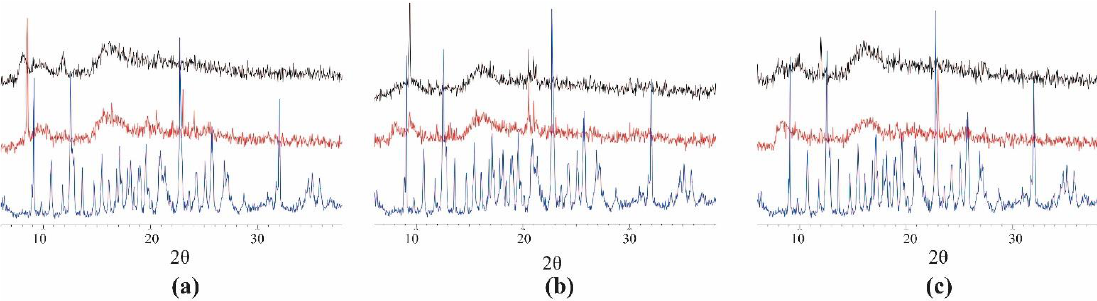
Figure 5. The powder XRD patterns of ( a ) Chlorpropham, ( b ) Monuron, ( c ) Propanil. Black is the co-precipitation complex, red is the pesticide, and blue is the β -CD.